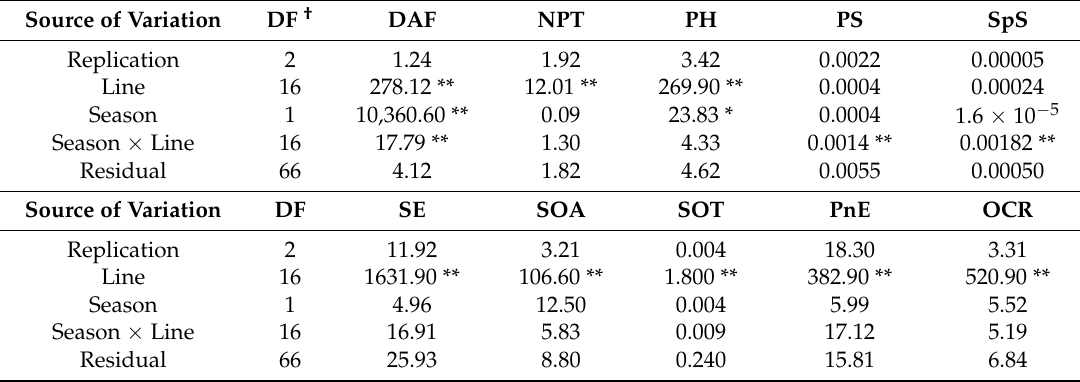
Table 4. Analysis of variance for agronomic and floral traits in 17 newly-bred cytoplasmic male sterility (CMS) lines.